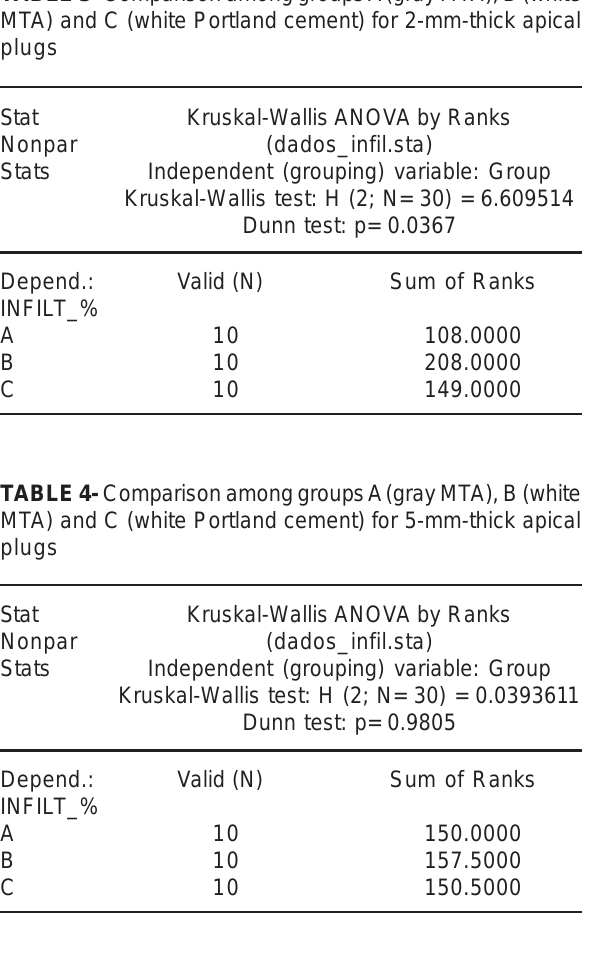
TABLE 3- Comparison among groups A (gray MTA), B (white